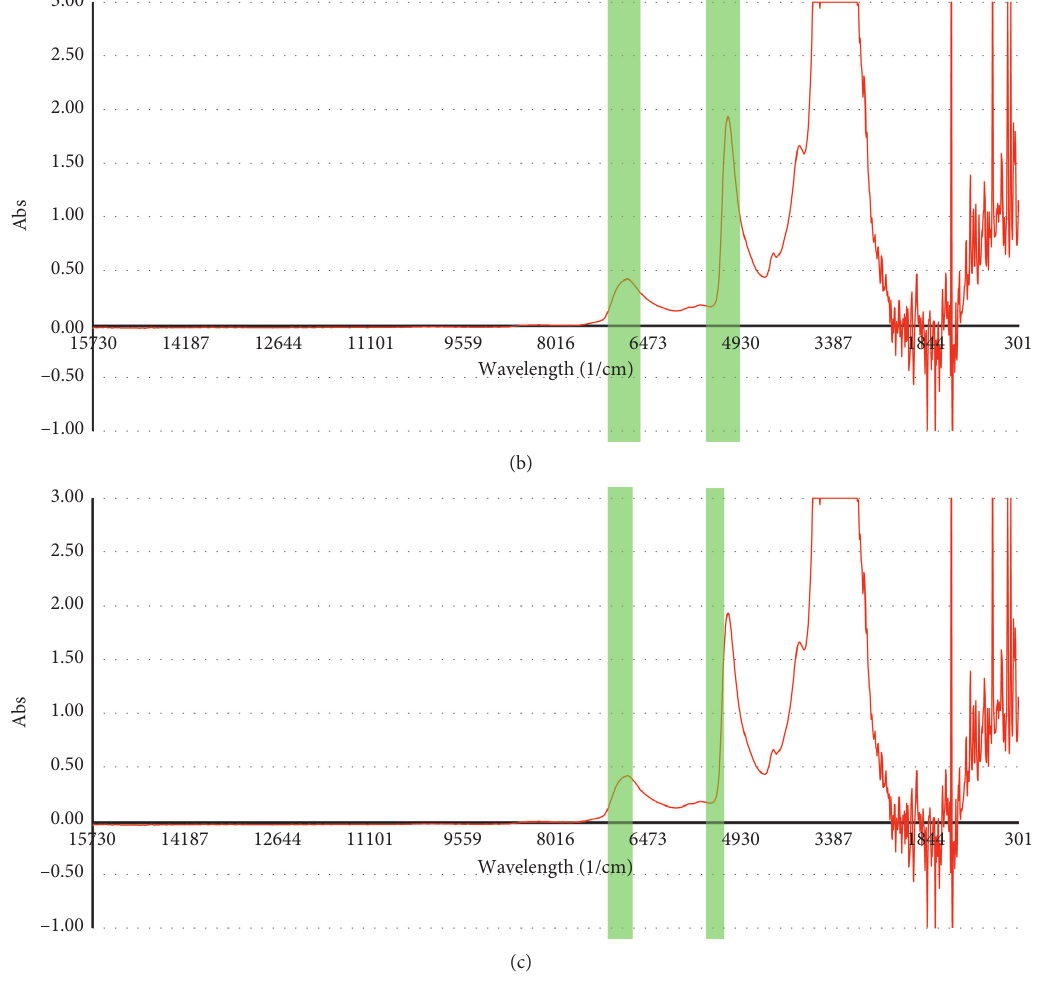
2 , and (c) water calibration model.